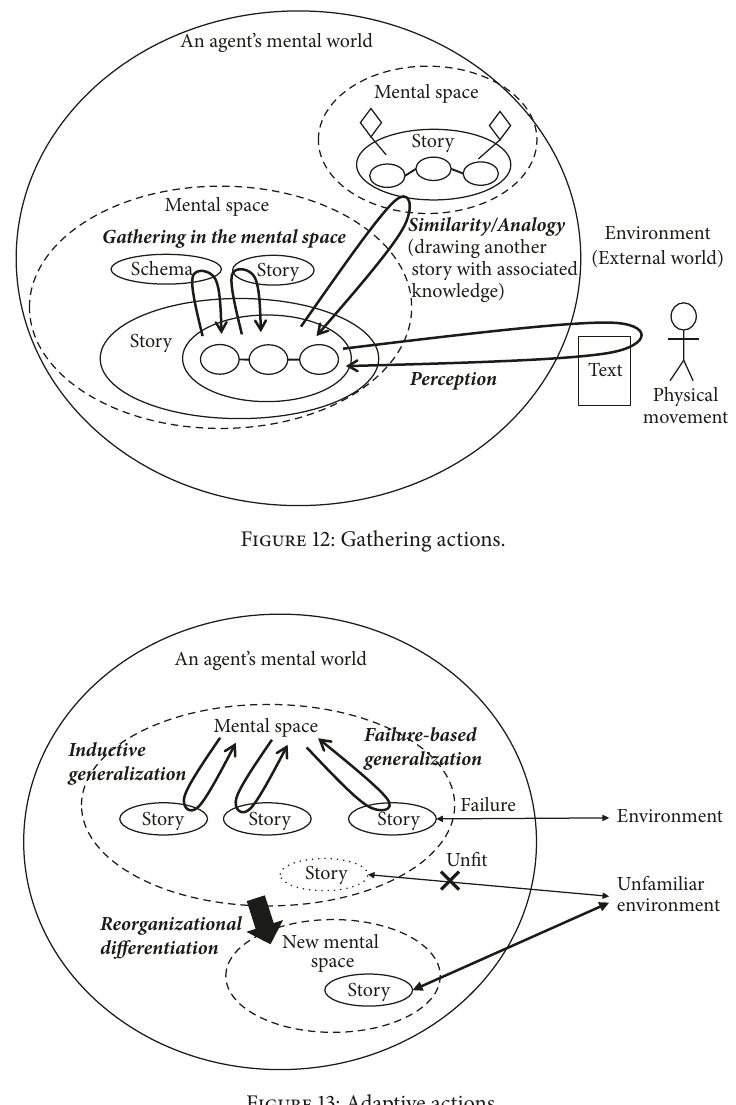
Figure 13: Adaptive